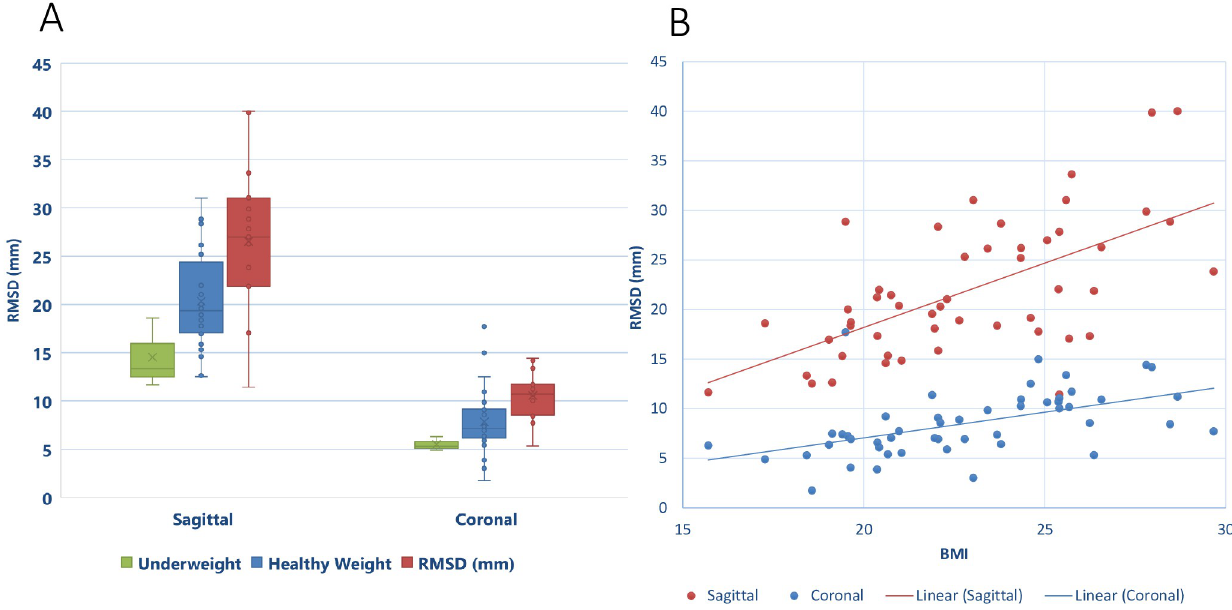
Fig 3. Comparison of the influence of BMI on the fiducial marker—Spinous process RMSD between the coronal and sagittal planes. The y–axis shows the RMSD between the spinous process profile and surface fiducial marker profile within each plane of view. (A) shows a box-plot with underweight (n = 3), healthy weight (n = 32) and overweight (n = 15) BMI categories for each plane. (B) shows a scatter-plot with the BMI of each participant in the x-axis, where the overall RMSD for the sagittal (red) and coronal (blue) is plotted and a linear trendline is fitted. Both the sagittal and coronal views show an increase in RMSD with BMI (B), in the sagittal view it appears BMI also increases the standard deviation (A).